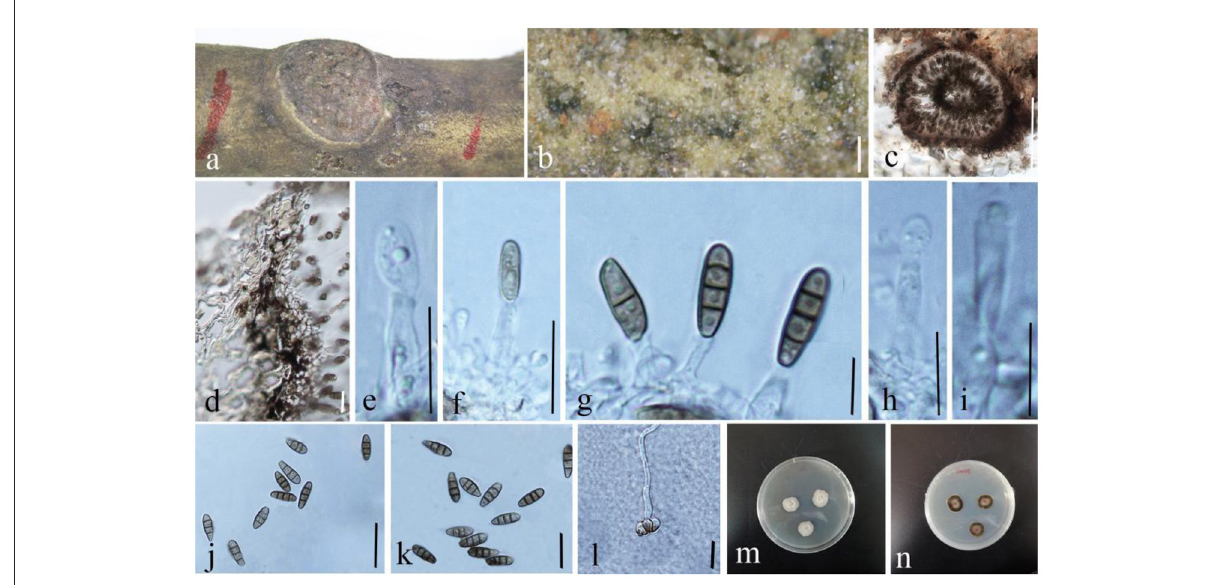
FIGURE9 Phragmocamarosporium magnoliae (GMB1388, holotype). (a) Dead branch of M. grandiflora . (b) Appearance of conidiomata on host. (c) Vertical section of conidioma. (d) Pycnidium wall. (e–i) Developing and matured conidia attached to conidiogenous cells. (j,k) Conidia. (l)